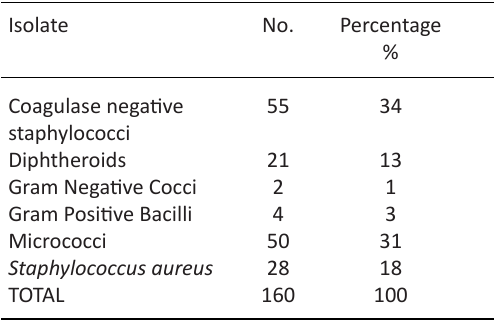
Table 3. Mannitol fermentation among the isolates Isolates No.